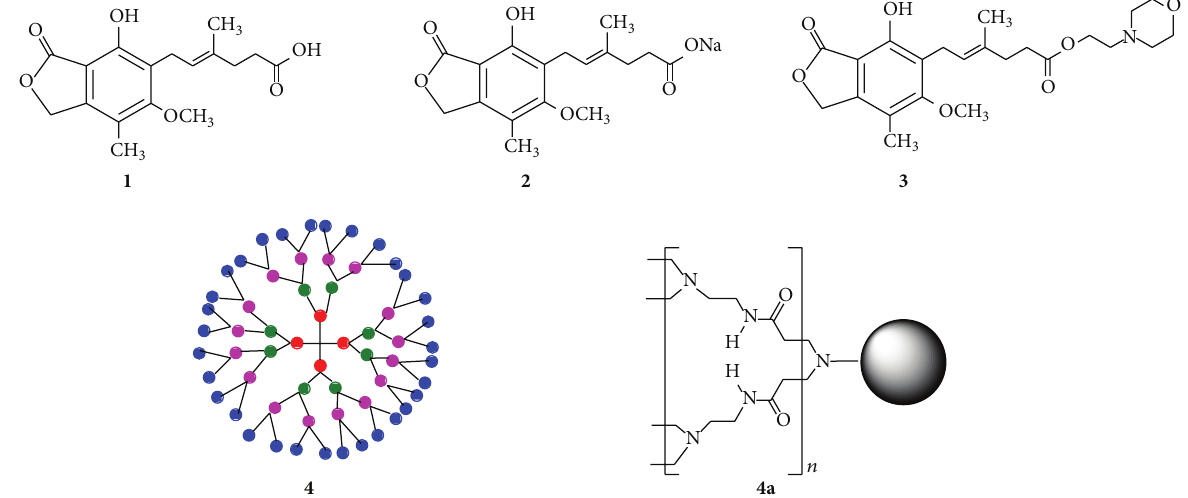
Figure 1: Mycophenolic acid ( 1 ) and its marketed derivatives ( 2 ) and ( 3 ); schematic representation of the structure of a generic dendrimer ( 4 ) and of a single PAMAM branch ( 4a